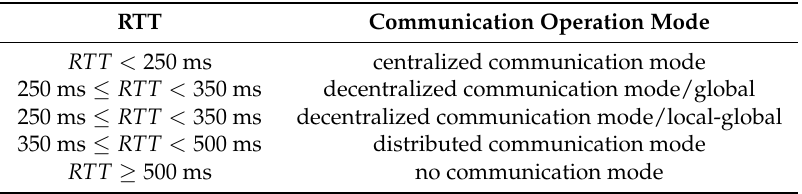
Table 1. Ruleset for the communication system operation.